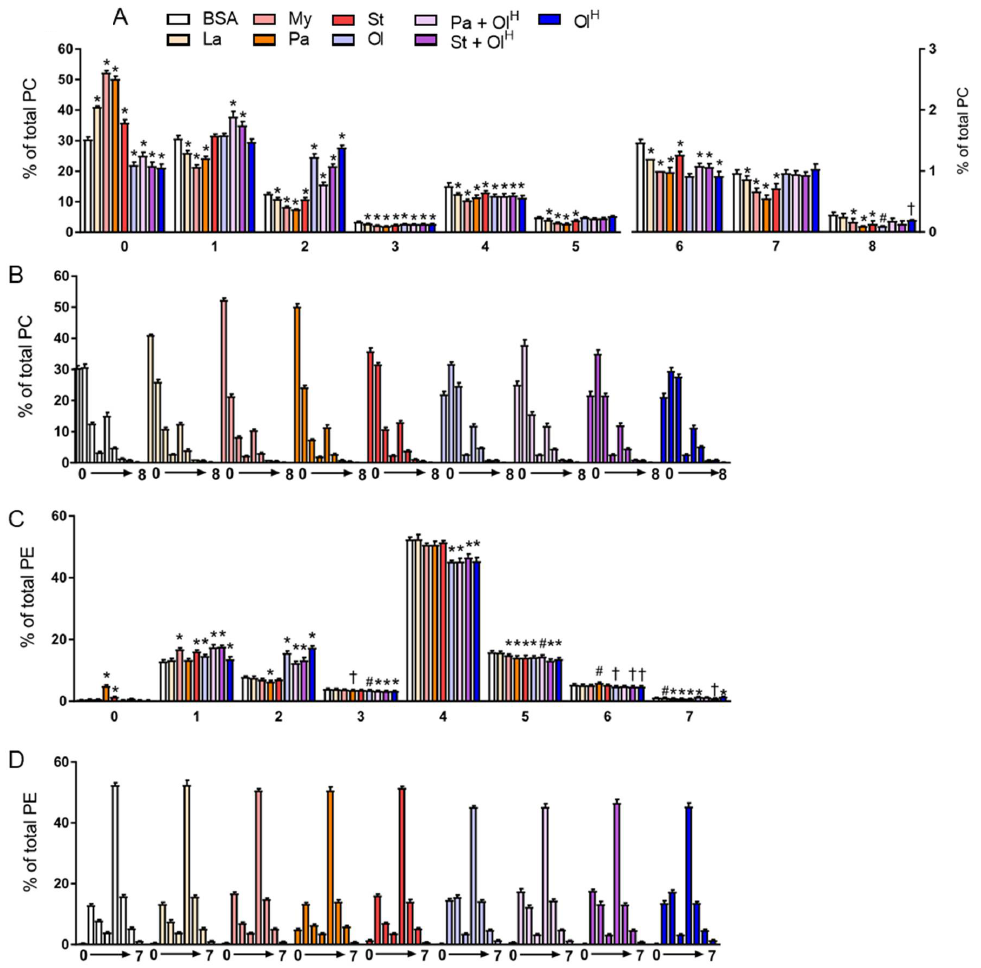
Figure 5. The effects of fatty acids on the saturation of PC and PE. Data in ( A – D ) are the mean + SD. Data are expressed in two ways; in A and C the various fatty acid treatments are grouped according to the number of double bonds present, whereas in B and D the data are grouped by the specific fatty acid (or the BSA control). Symbols represent statistical significance compared with BSA at the following α levels: * p ≤ 0.001; † p ≤ 0.01; # p ≤ 0.05. Data are from 6 independent mice.